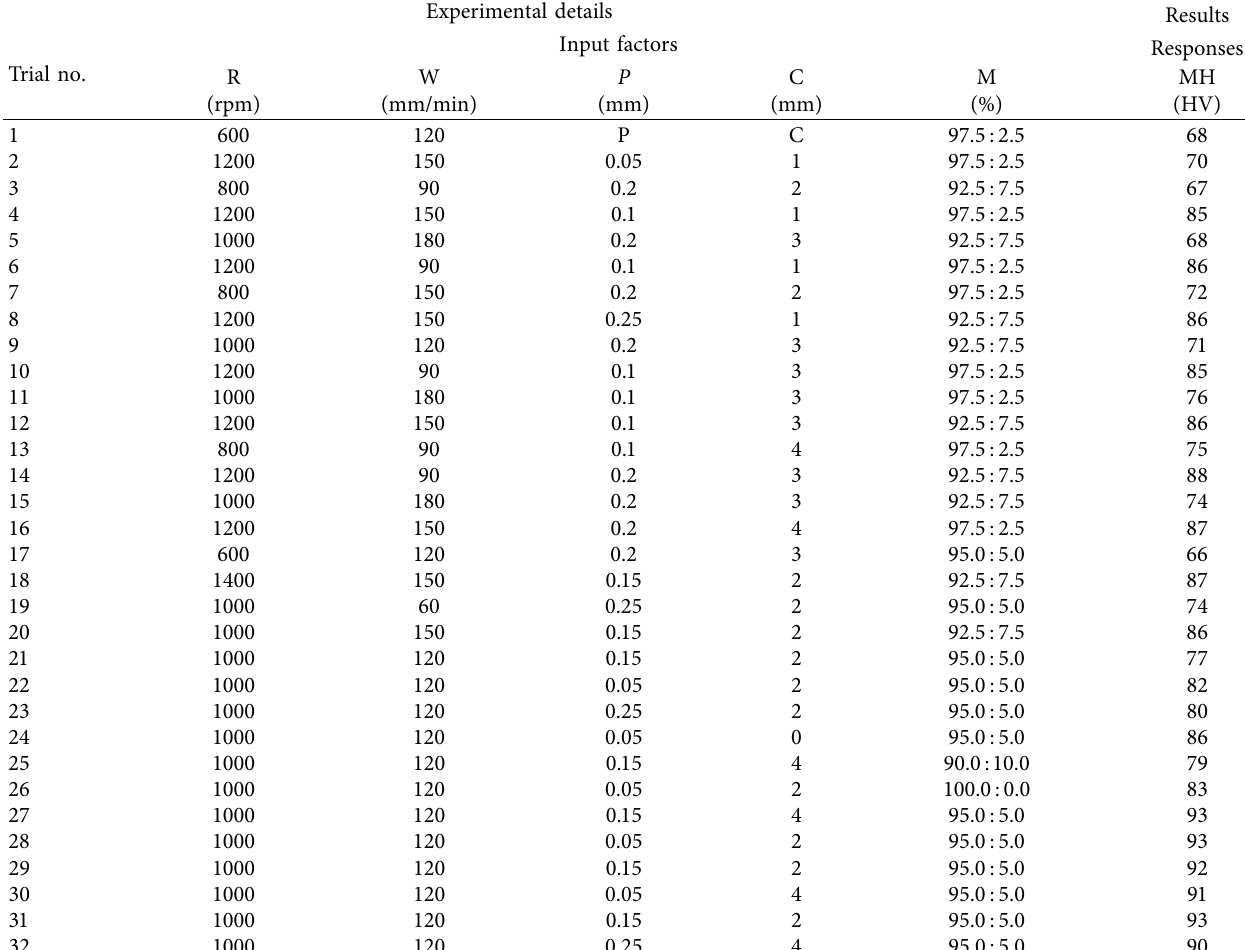
Table 7: Design matrix for